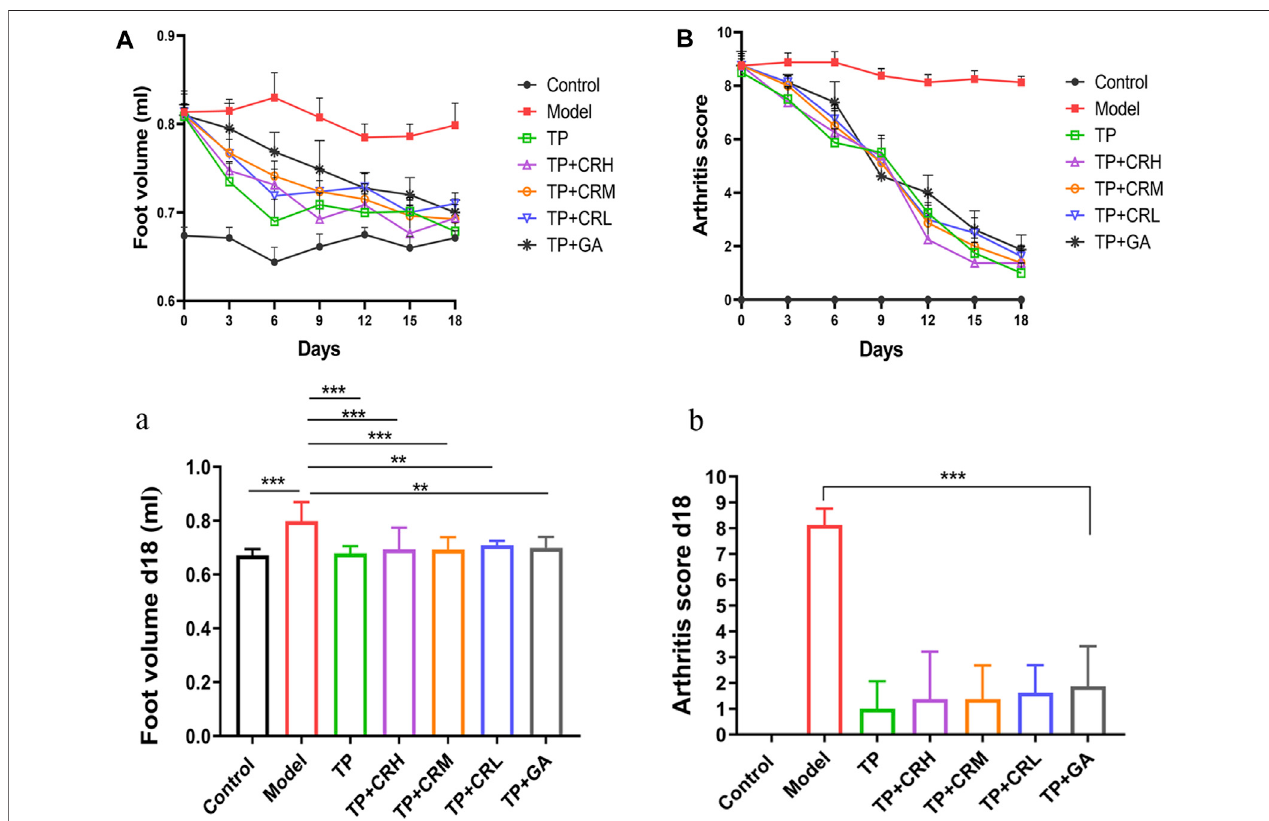
FIGURE 4 | Changes in arthritic foot volume ( (A) /a) and arthritis scores ( (B) /b) in the CIA mice through the administration course (n = 8). ** p < 0.01, *** p < 0.001 vs Control. CIA: collagen-induced arthritis.